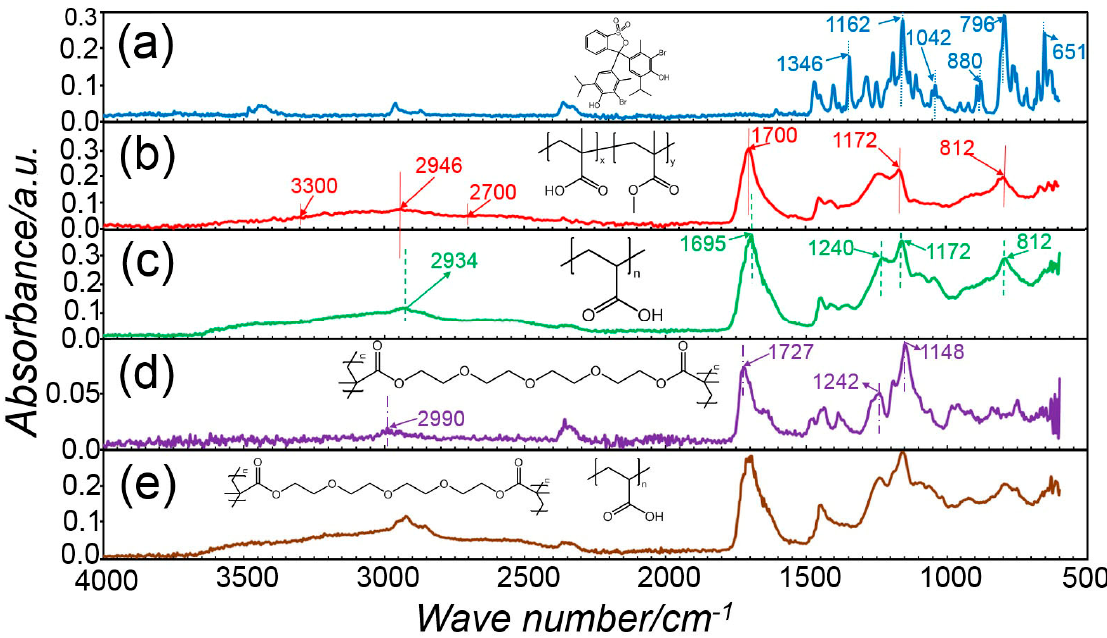
Figure 6. ATR ‐ FTIR spectra of BTB raw material ( a ), PAA fibres ( b ), sample PAA * ( c ), PMMA ‐ co ‐ MAA Figure 6. ATR-FTIR spectra of BTB raw material ( a ), PAA fibres ( b ), sample PAA* ( c ), PMMA-co-MAA fibres ( d ), and sample CS ‐ PAA12 ‐ (PMMA ‐ co ‐ MAA) ( e ), with respective chemical formula. fibres ( d ), and sample CS-PAA12-(PMMA-co-MAA) ( e ), with respective chemical